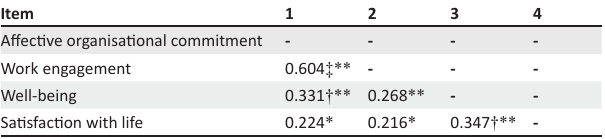
TABLE 3: Pearson-momentum correlation coefficients.